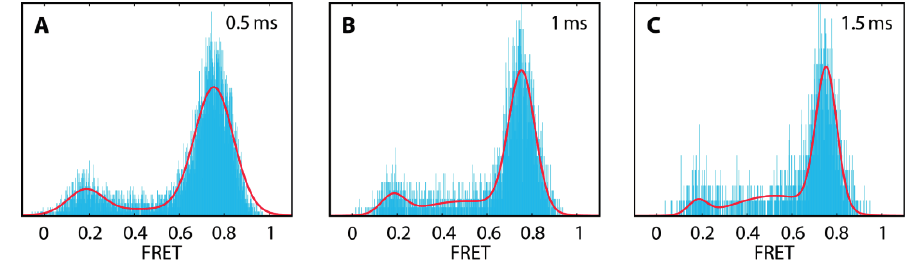
Figure 7. Global fit of the DNA hairpin construct hpT approximation [65]. The three FRET efficiency histograms were obtained from different bin times: 0.5 ms ( A ), 1 ms ( B ) and 1.5 ms ( C ). A small FRET bin size of 0.001 was chosen to minimize bin size